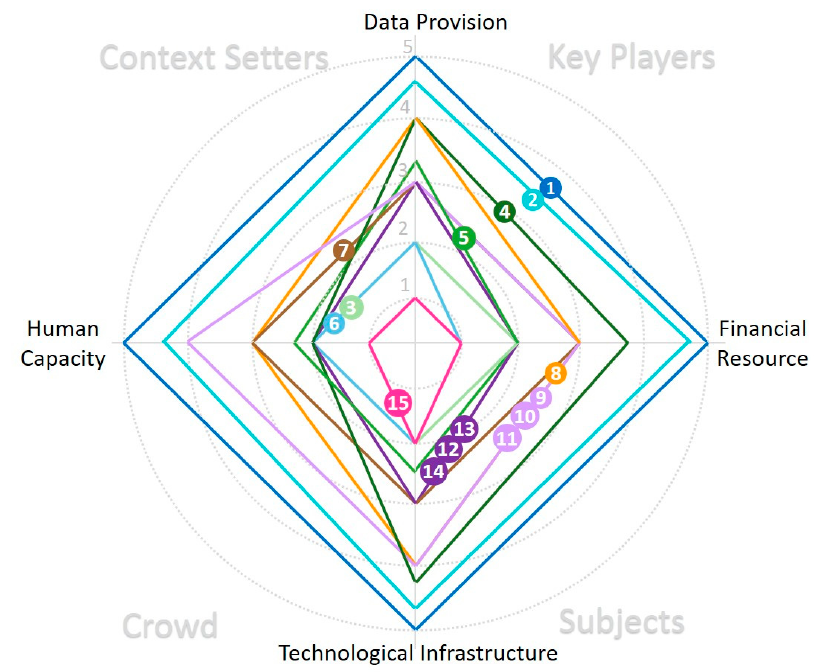
Figure 8. National spatial data infrastructure stakeholder diagram.